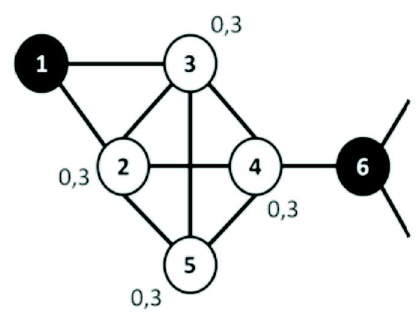
Figure 1. An example of how the game would proceed in a fragment of a network – no variation of thresholds